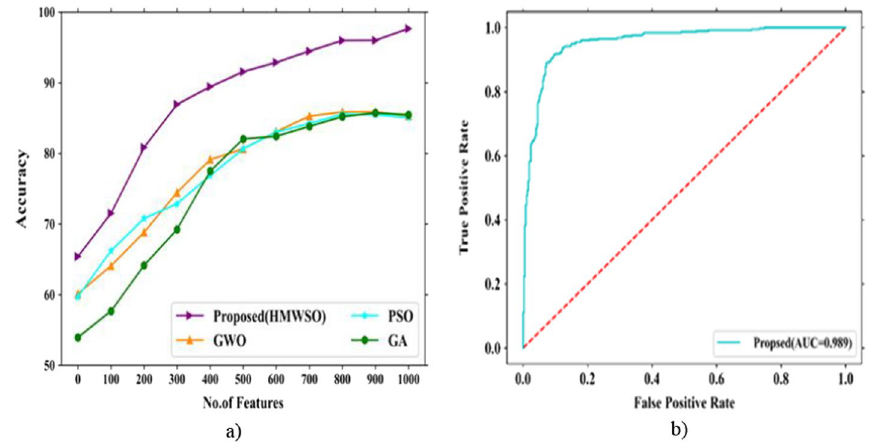
Fig. 9 a Accuracy vs no of features b ROC